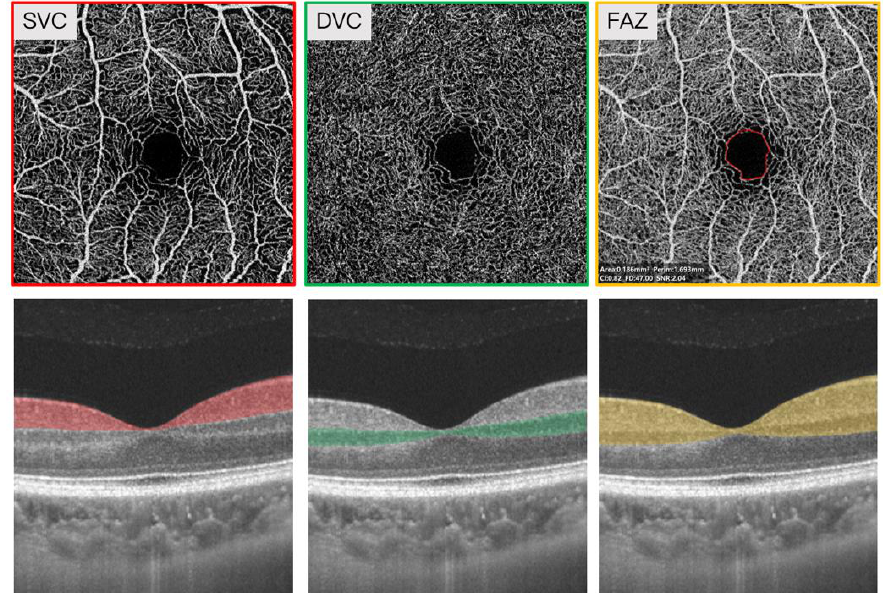
Figure 1. Representative 3 × 3 mm image of the superficial vascular complex (SVC), deep vascular complex (DVC), and fovea avascular zone (FAZ) area around the fovea. The angiograms of the SVC, DVC, and FAZ area were automatically generated by the OCTA tool. The segmentation of the SVC and DVC was set in the inner two-thirds and outer one-third border of the ganglion cell inner plexiform layer (GCIPL). The top panel represents the en face angiograms of SVC, DVC, FAZ while the lower panel represents the segmentation of SVC, DVC, FAZ.